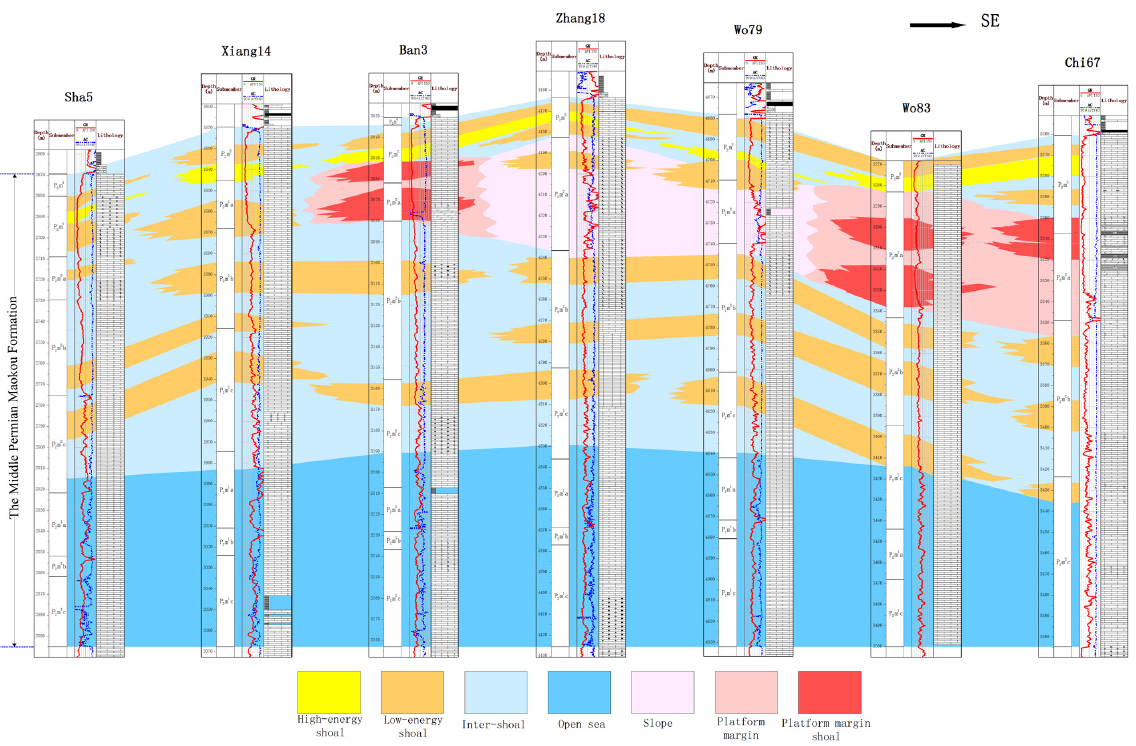
Figure 12. Sedimentary correlation section of wells Chi67-Wo83-Zhang18-Zhang8-Cheng20-QL12- QL3 in Eastern